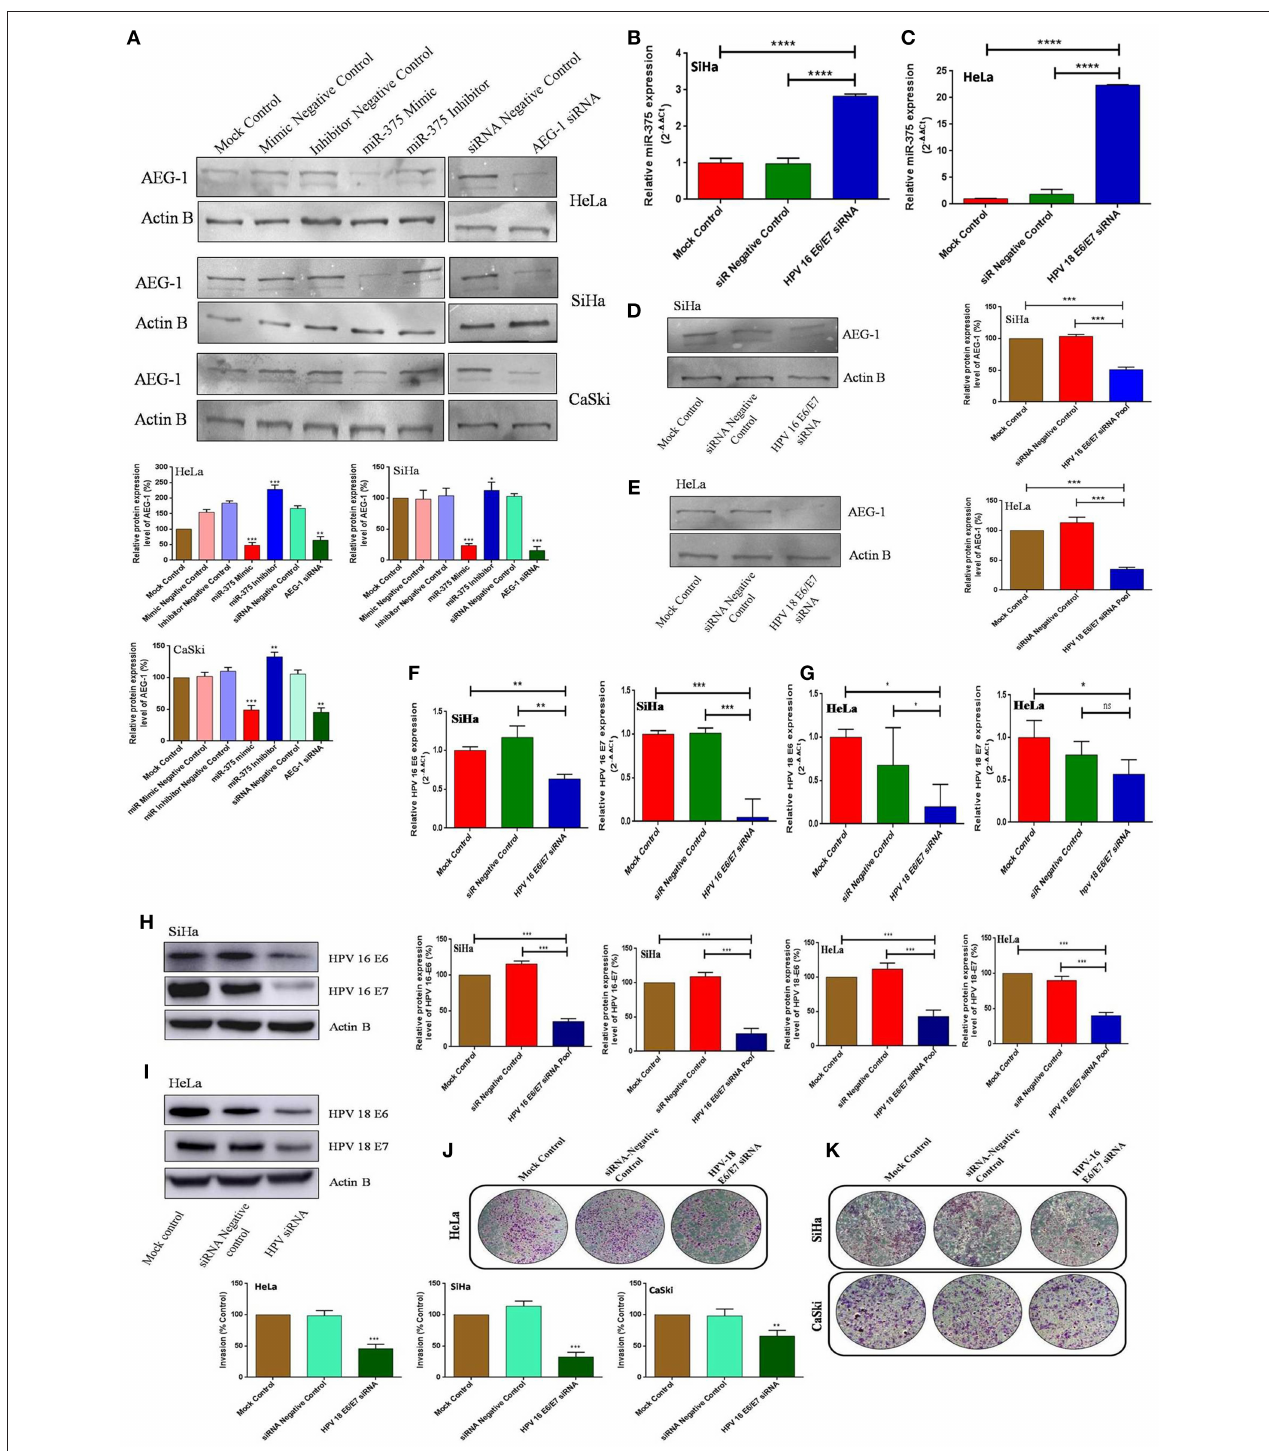
FIGURE 7 | miR-375 suppresses AEG-1 protein level and HPV regulates the miR-375 expression. Western blot validation of AEG-1 protein expression in CC cells after transfecting miR-375 mimic, miR-375 Inhibitor, AEG-1 siRNA and their controls with β -actin as the loading control (A) . Effect of HPV16, 18-E6/E7 siRNA on miR-375 expression in SiHa (B) and HeLa (C) cells were determined by qRT-PCR. Effect of HPV16, 18-E6/E7 siRNA on miR-375 targets AEG-1 protein expression in SiHa (D) and HeLa (E) cells were determined by western blot. Effect of HPV16, 18-E6/E7 siRNA on E6 and E7 mRNA expression in SiHa (F) and HeLa (G) cells were determined by qRT-PCR and protein expression were determined by western blot (H,I) . Transwell invasion assay with Matrigel was performed in HPV 18 E6/E7 siRNA, HPV 16 E6/E7 siRNA and their controls transfected CC cells (J,K) . Error bars represent mean ± s.d. and P- values are represented as * p < 0.05, ** P < 0.05, *** P < 0.001 and **** p < 0.0001, ns – non significant compared to the corresponding controls.